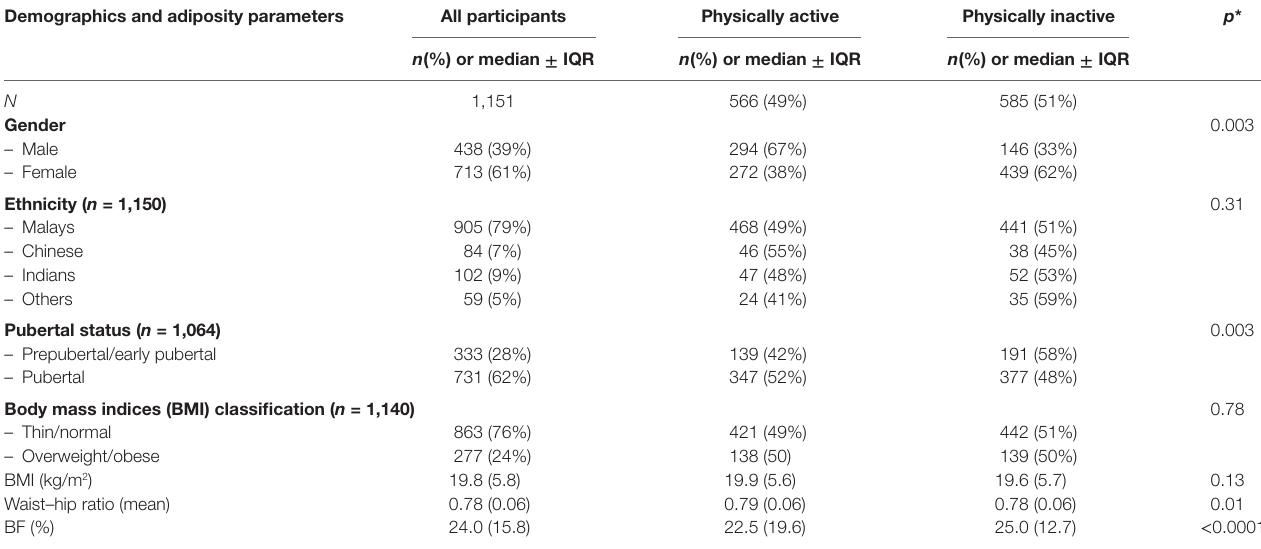
TaBle 1 | Demographics and adiposity parameters of Malaysian adolescents from the Malaysian Health and Adolescents Longitudinal Research Team study comparing physically active and inactive participants. Demographics and adiposity